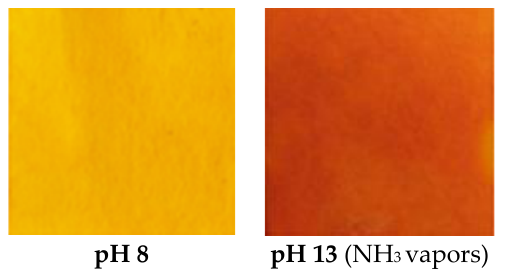
Figure 6. Fluorescent response of strip papers based on 1,8-naphthalimide 7 at different pHs.